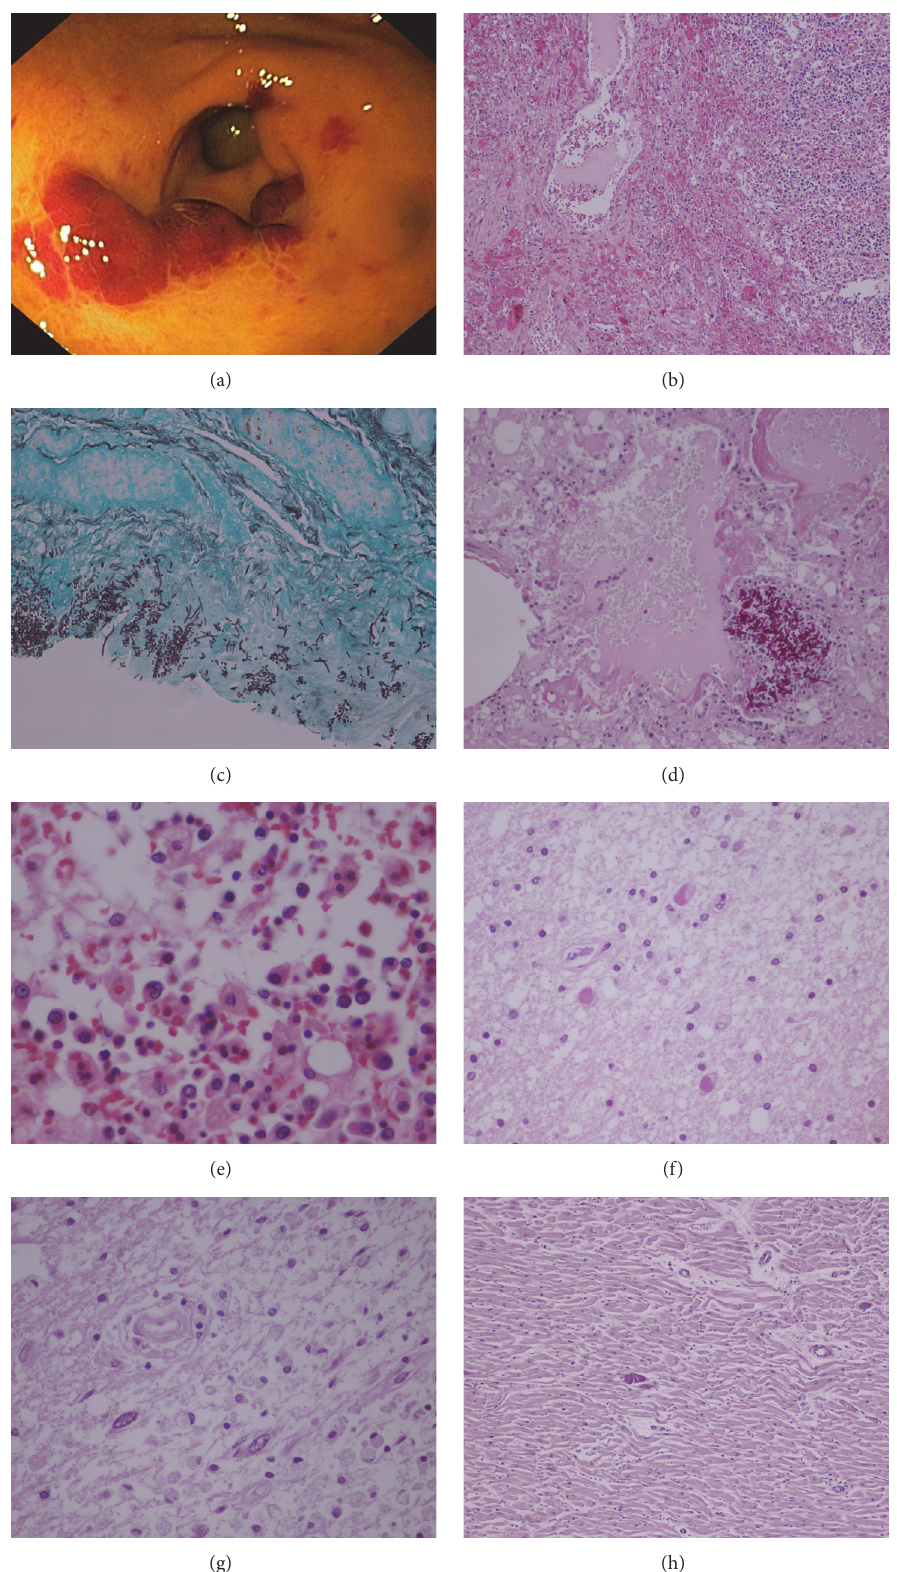
Figure 1: (a) Gastric Kaposi sarcoma: scarlet slightly elevated lesions of the antral gastric mucosal surface (upper gastrointestinal endoscopy). (b) Mediastinal ganglia Kaposi sarcoma: submucosal vascular spindle-shaped cells (H&E-stain, 100x). (c) Candida spp. in colon (Grocott methenamine silver-stain, 100x). (d) Candida spp. in lung and hyaline membranes suggesting acute respiratory distress syndrome (H&E- stain, 100x). (e) Bone marrow hemophagocytosis (H&E-stain, 400x). (f) Progressive multifocal leukoencephalopathy: enlarged homogeneous oligodendrocyte nucleus with inclusion (H&E-stain, 100x). (g) Cerebral toxoplasmosis: Toxoplasma cyst (H&E-stain, 100x). (h) Cardiac toxoplasmosis: Toxoplasma cyst (H&E-stain,